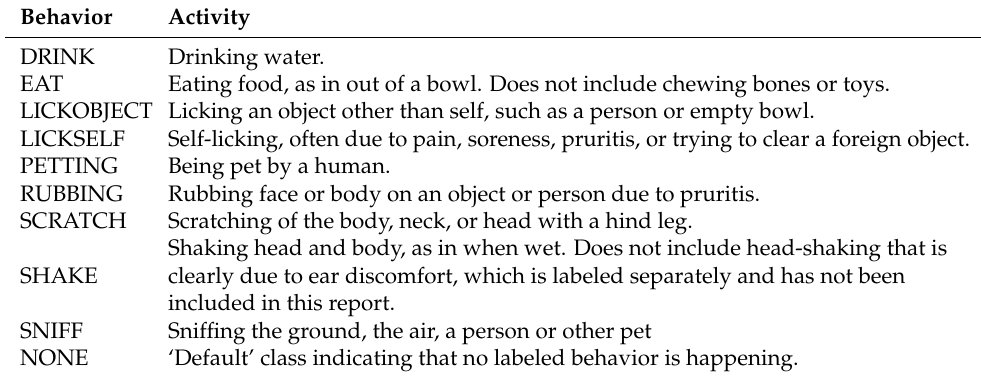
Table 3. Behaviors